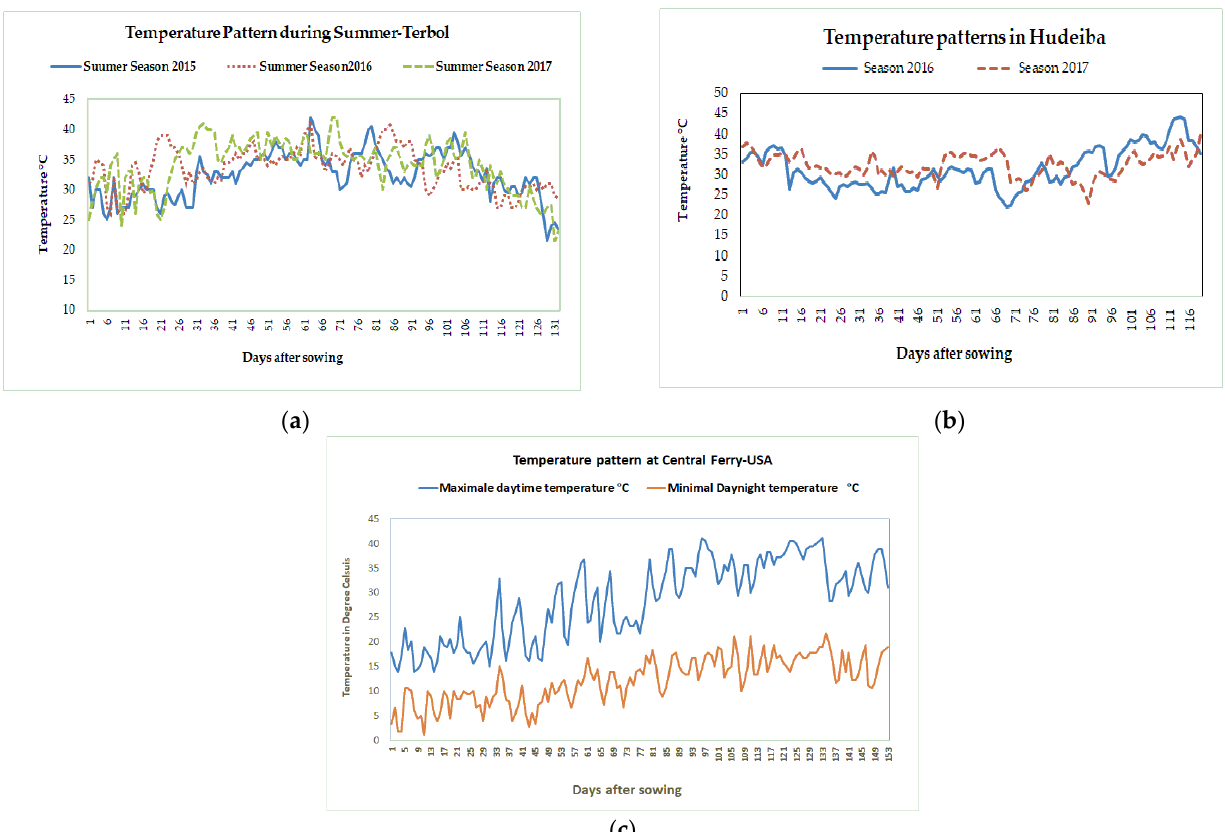
Figure 3. Variation in maximal temperature during the growing seasons from 2015–2017 at Terbol, Lebanon ( a ), Hudeiba, Sudan ( b ), and Central Ferry, WA, USA ( c ).